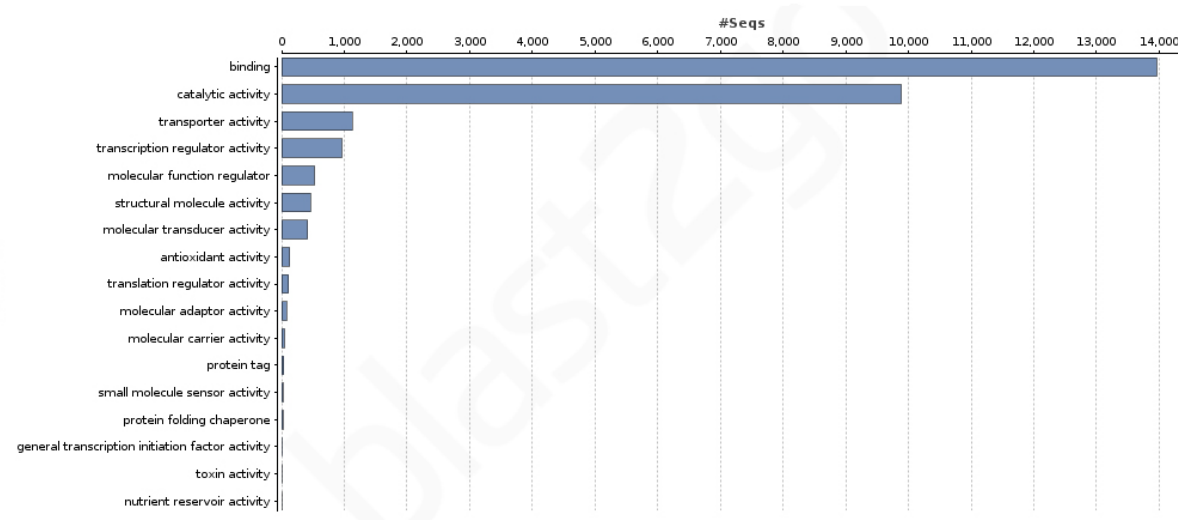
Figure 3. Distribution of the GO terms in the second GO hierarchical level for the molecular function category.